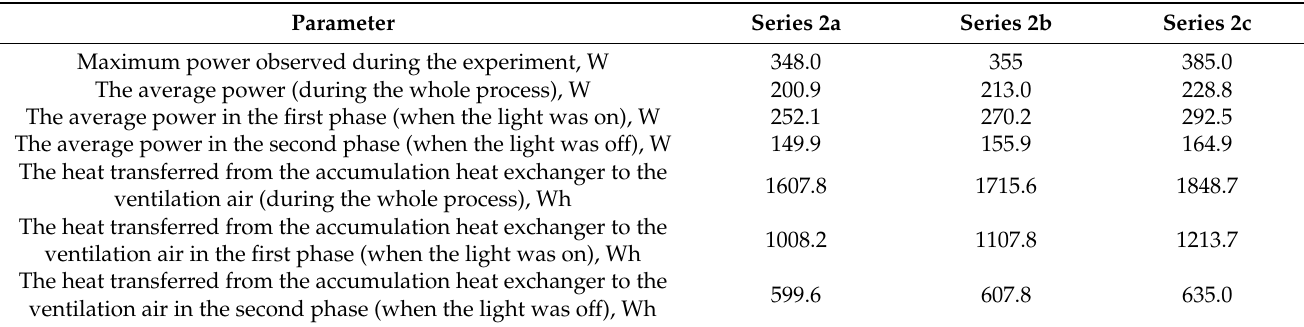
Table 8. Summarization of the power transferred from the SAH to the ventilation air when the SAH operated as a solar chimney and airflow was set to 100 m 3 /h (Series 2a), 150 m 3 /h (Series 2b), and 200 m 3 /h (Series 2c).